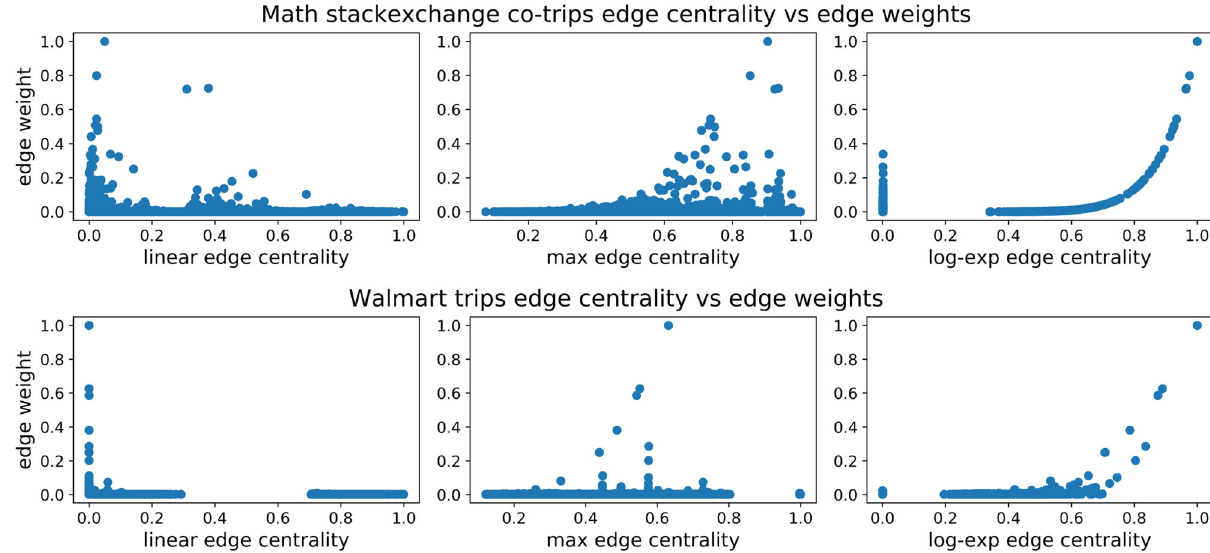
Fig. 4 Scatter plots of edge weights and centralities. Scatter plots comparing the edge weights against the edge centrality score computed with the "linear'', "log-exp'', and "max'' centrality models on the Math stackexchange co-tags and the Walmart trips hypergraphs. Each dot in the panels represents a hyperedge e , with coordinates ( x e , y e ), where x e corresponds to the centrality value assigned to e by one of the three models, whereas y e = w ( e ) is the weight of e in the